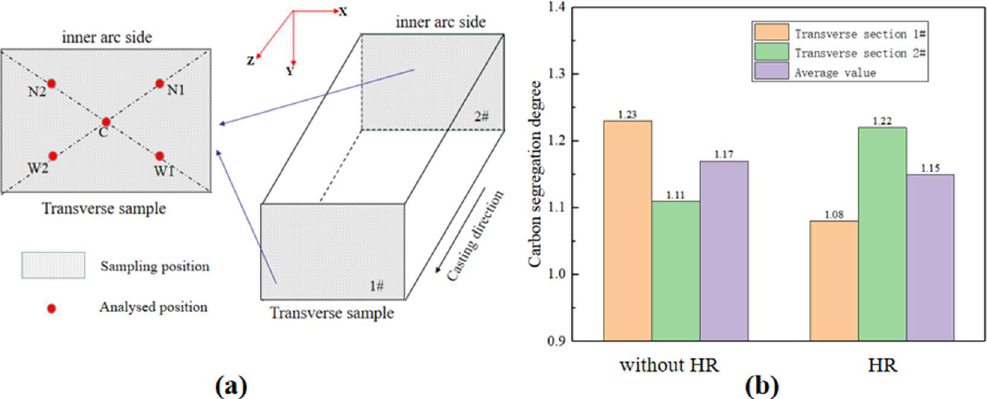
Figure 15. Schematic diagram of ( a ) sampling positions and ( b ) comparison of carbon segregation at different positions.